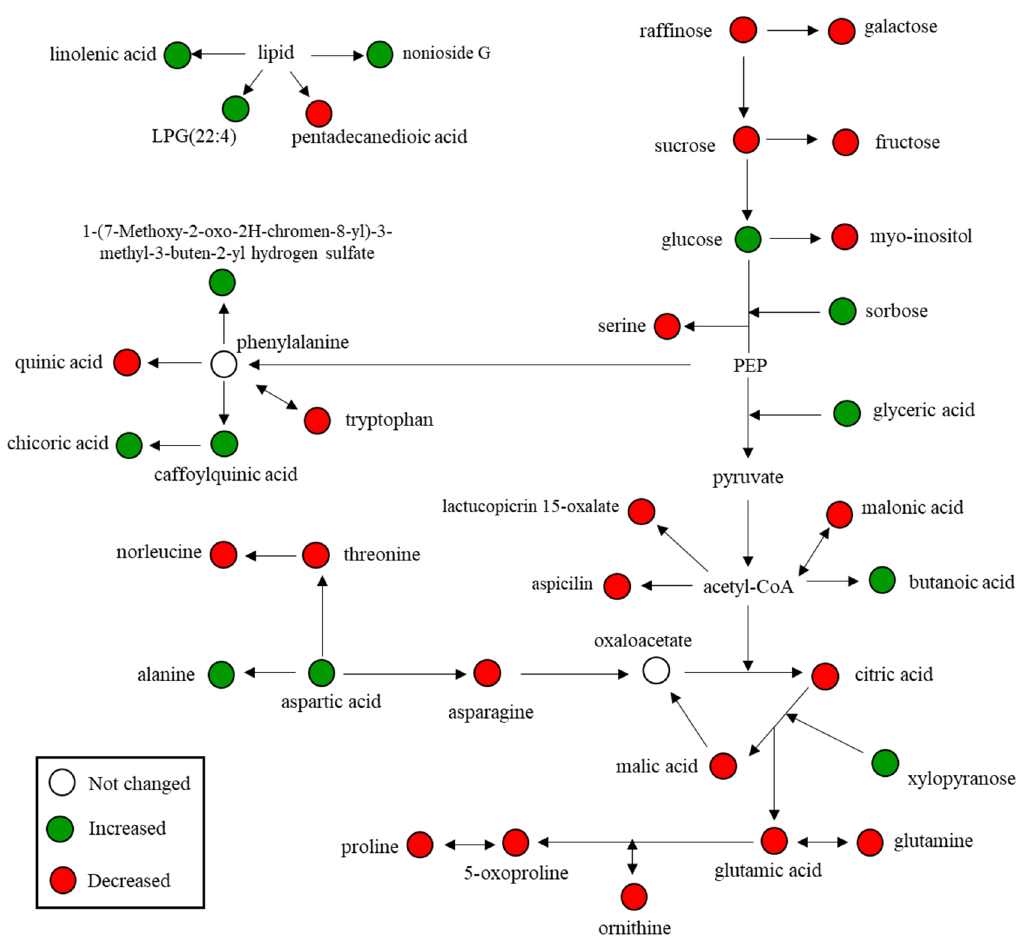
Figure 7. Schematic of the lettuce metabolic pathway associated with the sulfur treatment. The metabolites analyzed using LC-MS and GC-MS are shown in color. Green indicates increased metabolites, red indicates decreased metabolites, and the open circles indicate no change.